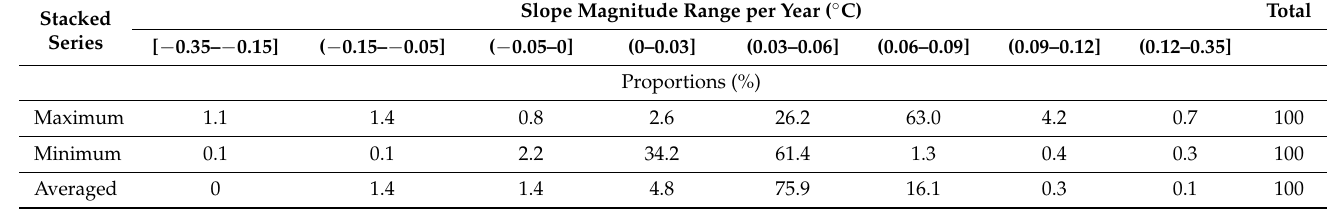
Table 1. The proportion (%) of different slope magnitude ranges of the Baltic Sea surface temperature (SST) based on annual maximum SST, annual minimum SST, and their average values over the last four decades.